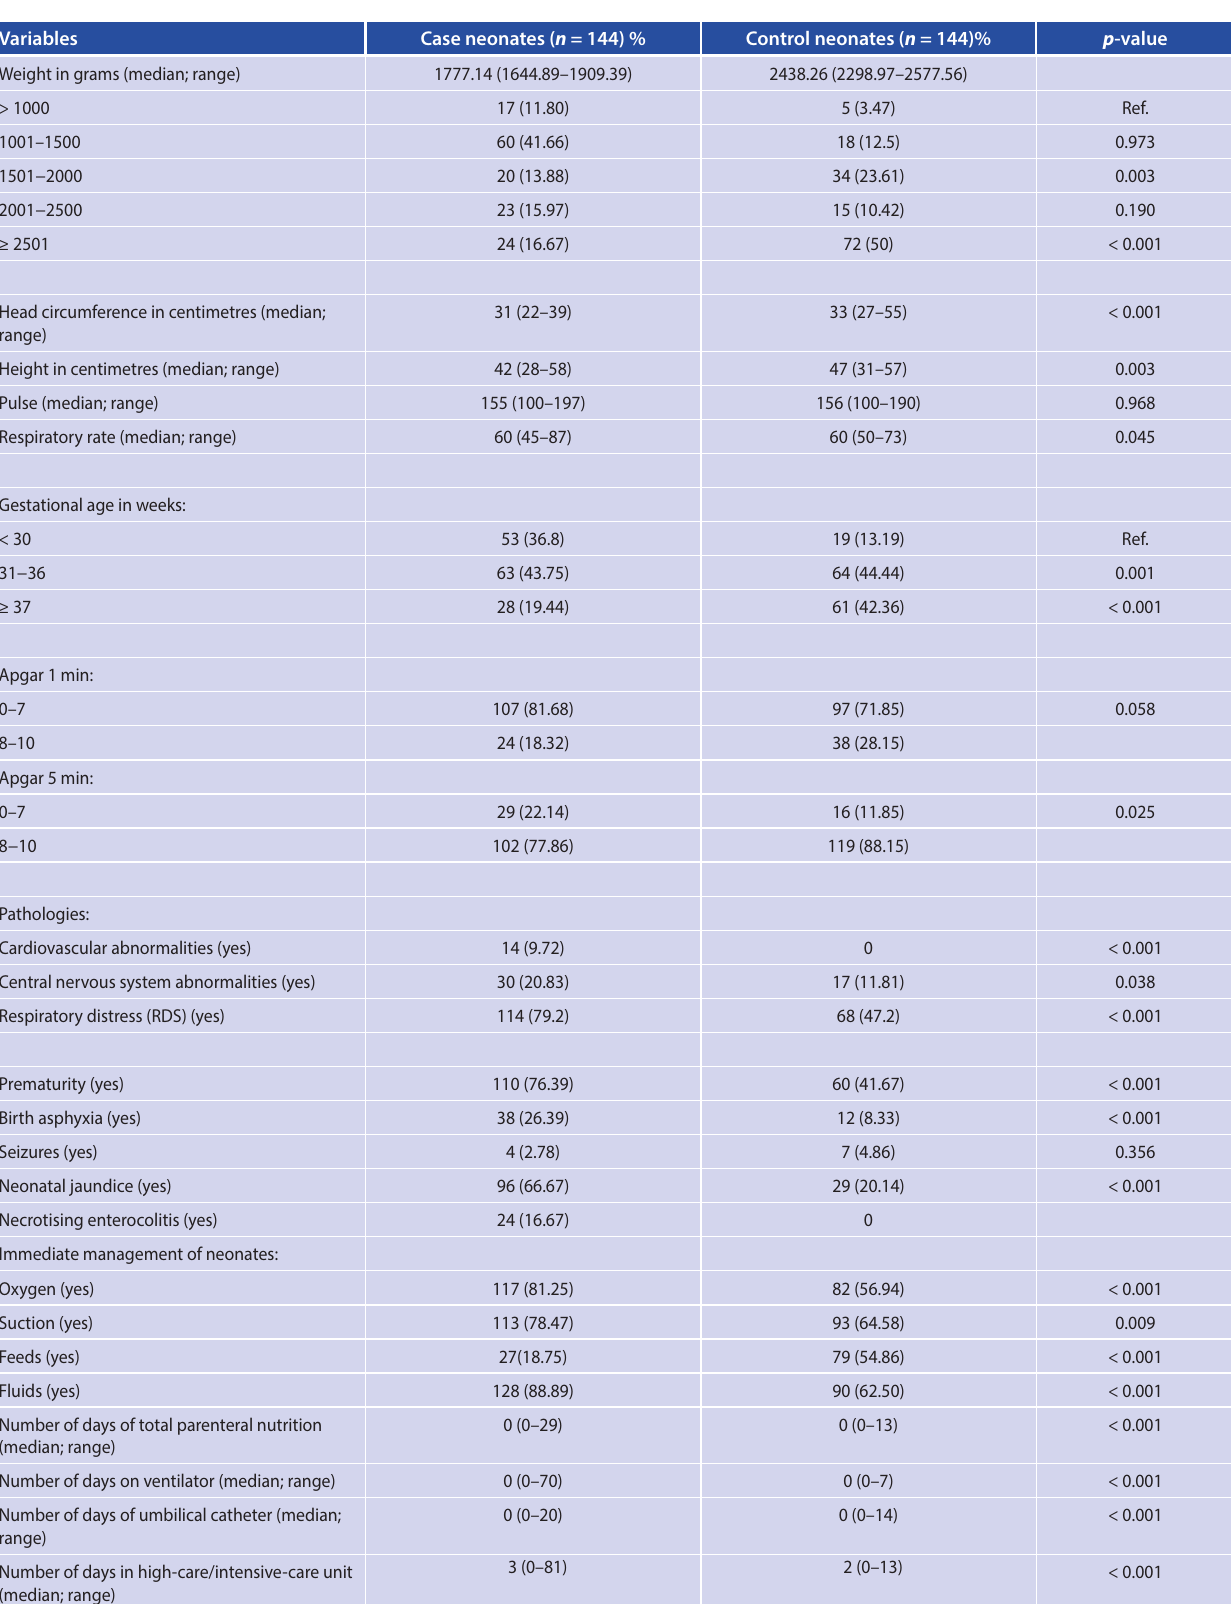
Table 2: Neonatal demographic profiles of hospitalised neonates in NICU from 2014 to 2015 ( n = 288)